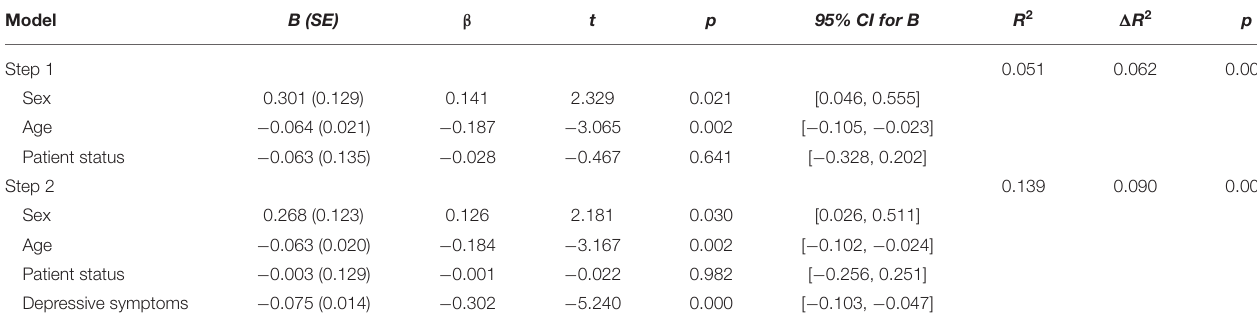
TABLE 5 | Regression analysis: individual quality of life.